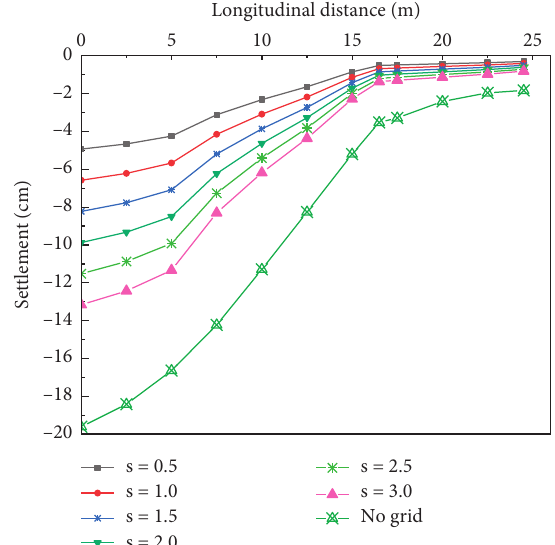
Figure 10: Settlement of the top surface of the subgrade at different grid laying locations.